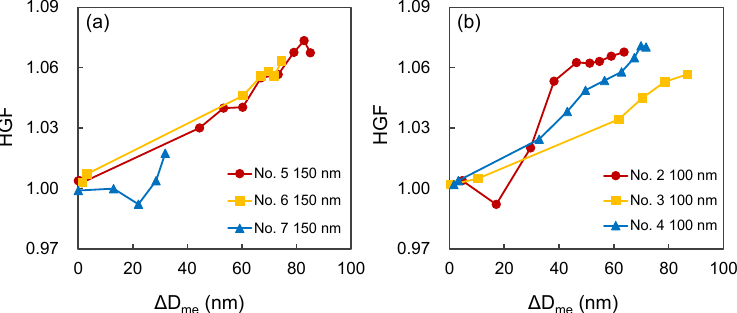
Figure 10. Evolution of hygroscopic growth factors (HGF) of BC particles during ageing as a function of (cid:49)D me . (a) Three experiments with 100nm BC particles, (b) three experiments with 150nm BC particles. Different colours in each figure represent different experiments. Hygroscopicity measurement is not available for experiment